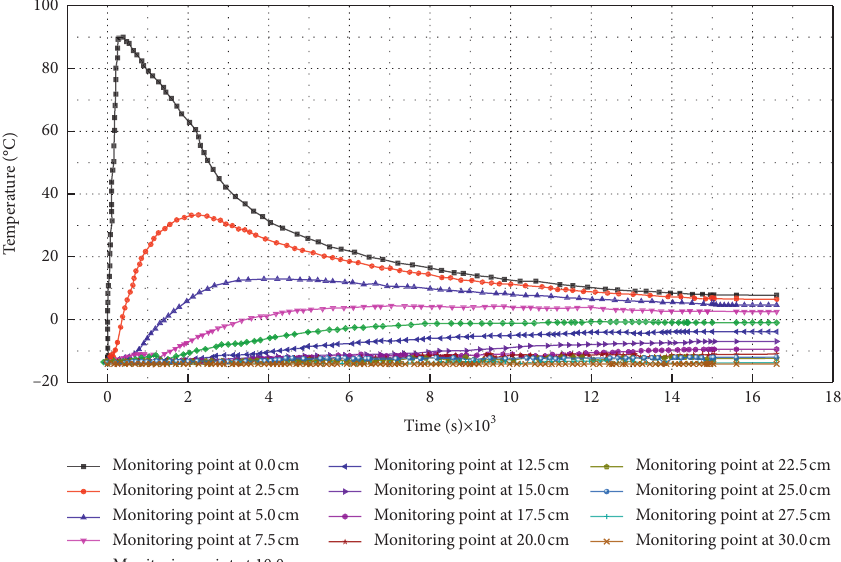
Figure 15: Temperature change over time at the monitoring points above the center of the frozen soil subgrade void region.